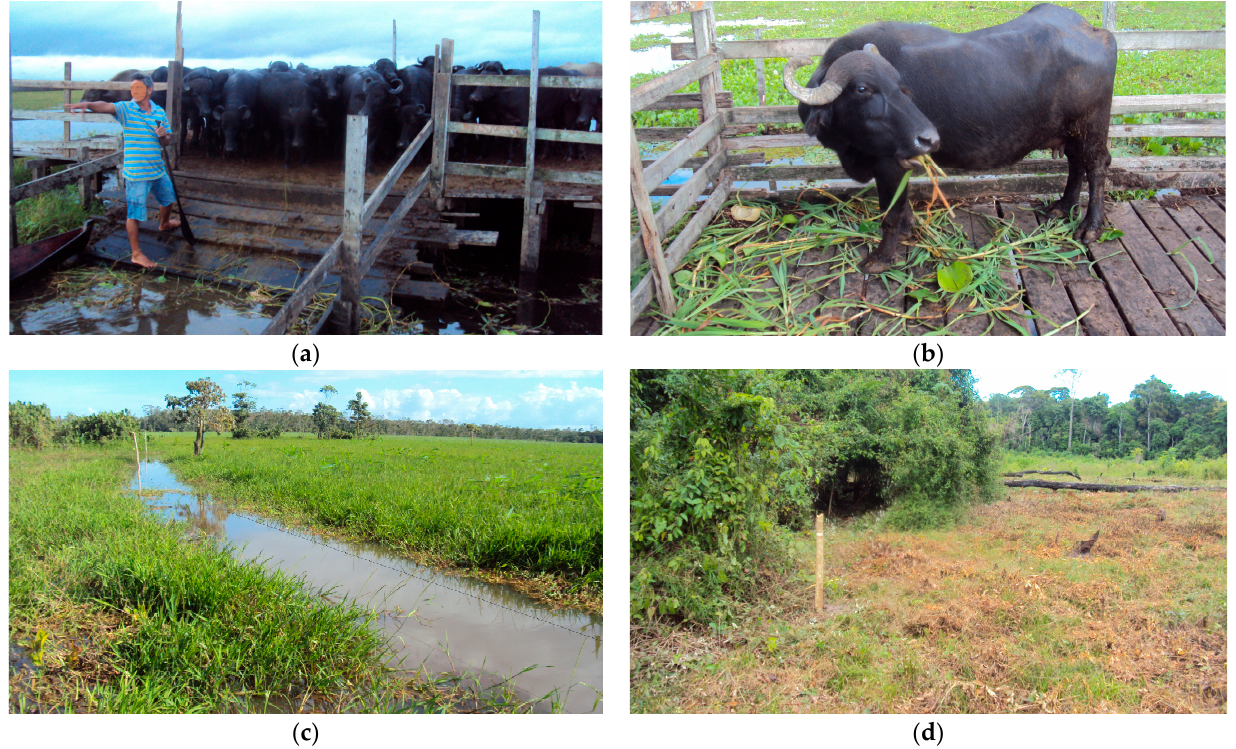
Figure 2. Main practices for buffalo ranching used in floodplain areas in Porto de Moz. ( a ) Stilt corral. In floodplain areas, buffaloes are reared in open areas during the day and sleep in stilt corrals during the night. ( b ) Pregnant cow in a stilt corral. Cows and their calves are kept in stilt corral in the pre and post-delivery during the flood season. ( c ) Rest area with electrical fence. These areas are either surrounded by wood boards or electrical fences. Some families keep the electrical fences in the flood season by lifting the wires according to the water level. ( d ) Grazing field planted in dry- land. One of the main challenges for farmers is the long-term maintenance of grass productivity since the reform of pastures are